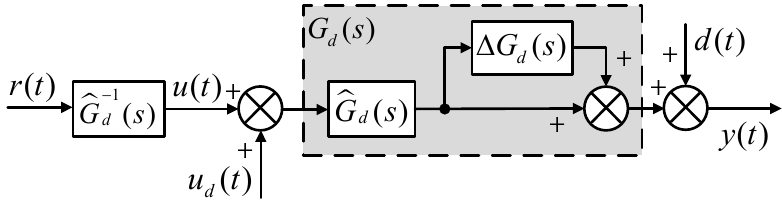
Figure 10. The proposed control scheme for dual-shaking table system.